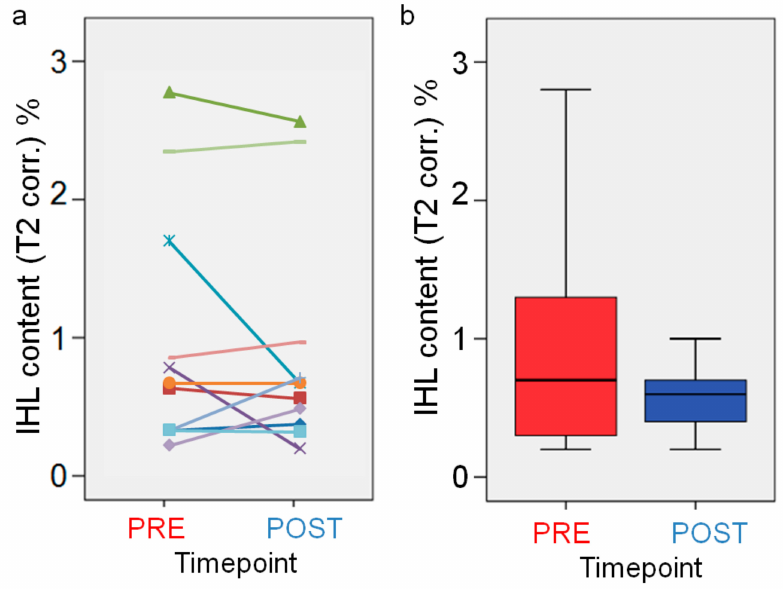
Figure 5. Mean intrahepatic lipid (IHL) values for PRE and POST measurements. Scatter plot of individual values ( a ) and box plots of grouped values ( b